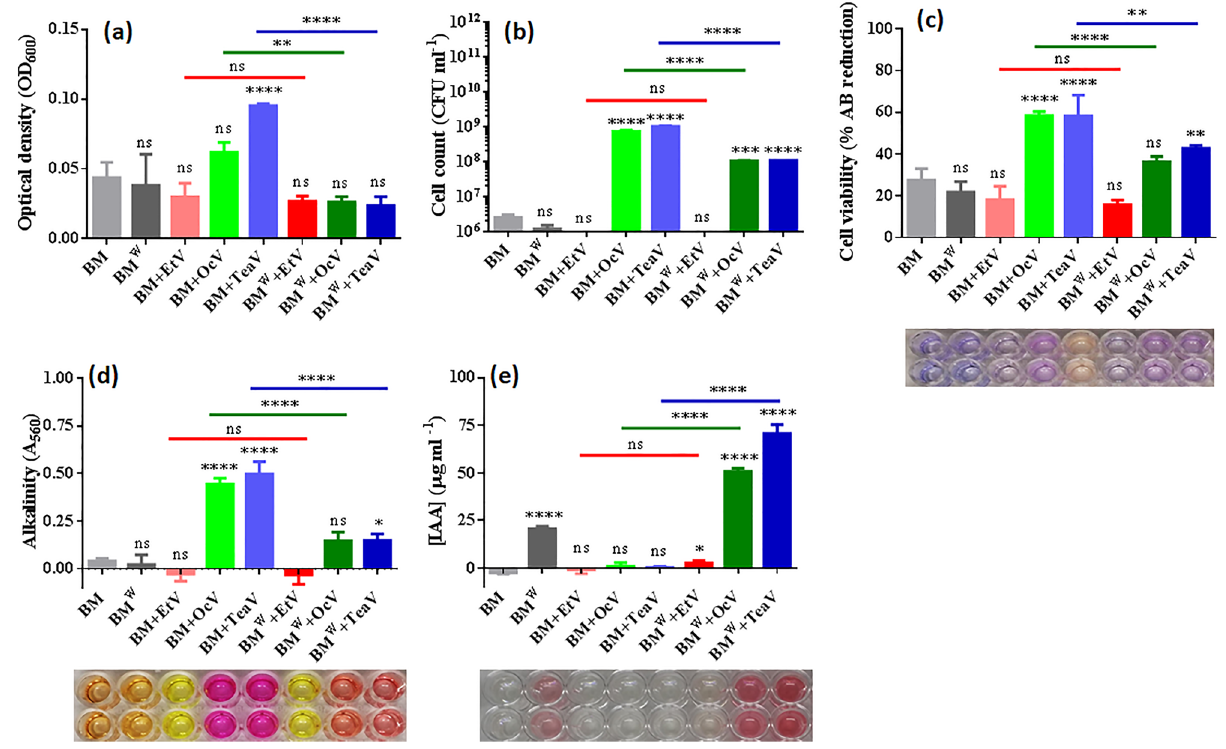
Figure 3. Influence of the vapors of ethanol (EtV), 1-octanol (OcV) and aqueous tea extract (TeaV) on Pseudomonas sp. NEEL19, cultured in DSMZ 125* without and with 0.1% (w/v) Trp (BM and BM W , respectively). ( a ) optical cell density (OD 600 ), ( b ) cultivable cell count, ( c ) cell viability, ( d ) media alkalization and ( e ) IAA production are shown; microplate sections obtained in this study ( c ‒ e ) represent corresponding chromogenic reactions. Inoculated Trp-fee DSMZ 125* without vapor treatment was used as a control. Error bar, mean (n = 4) ± s.d. * P < 0.1, ** P < 0.05, *** P < 0.01, **** P < 0.0001; ns, non-significant. Treatment codes are defined in the section